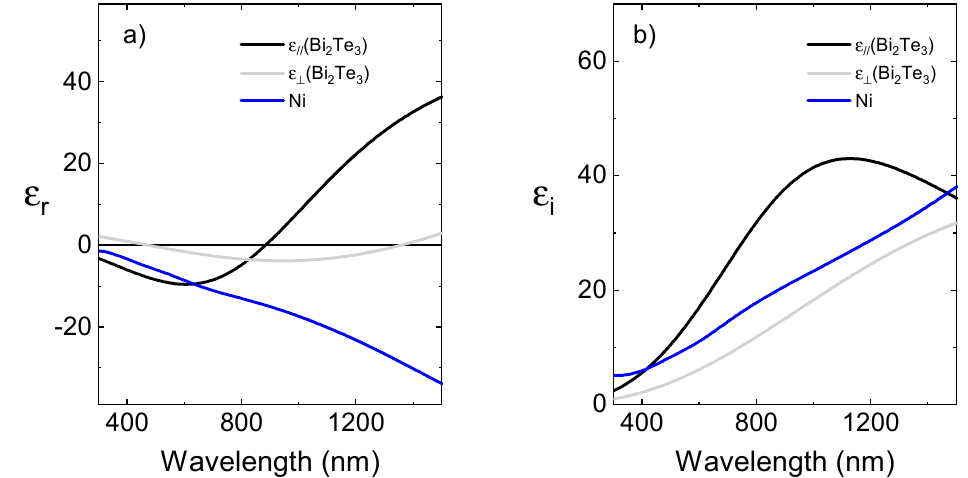
Figure A2. Dependence of the position of the peak of the imaginary part of the in-plane effective dielectric tensor for the case of Ni nanowire arrays as a function of the distance between the nanowires. Finally, the optical properties of the wire materials have been obtained from thick layers of Ni and Bi 2 Te 3 grown in the same conditions used to fill the templates. (See Figure A3).